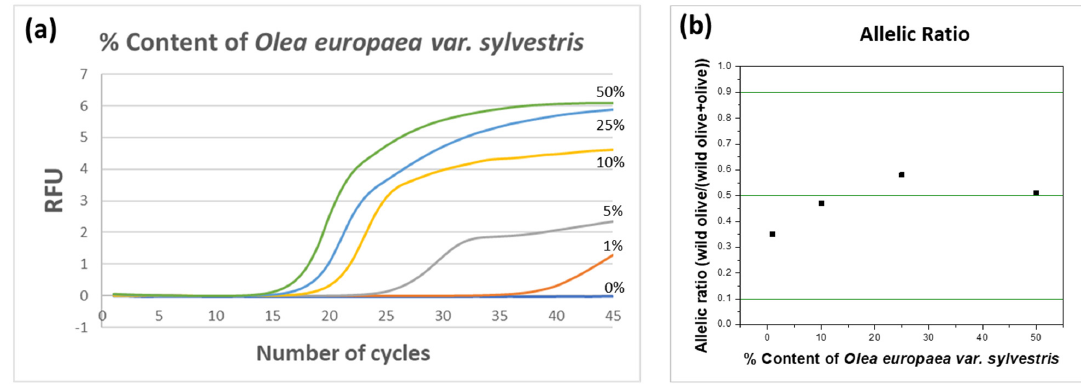
Figure 3. (a) The real-time PCR curves obtained for different % DNA content (0%–50%) of Olea europaea var Sylvestris (wild-type olive) DNA in binary mixtures with Olea europaea L . var Europaea (cultivated olive) DNA. (b) The allelic ratios of the binary DNA mixtures calculated as the ratio of the fluorescence intensity obtained with the upstream primer specific to Olea europaea var Sylvestris target versus the sum of the fluorescence intensity obtained by both allele-specific primers for Olea europaea var Sylvestris and var Europaea targets. All allelic ratios were close to the value of 0.5, which corresponds to a heterozygote sample. RFU: Relative Fluorescence Units.